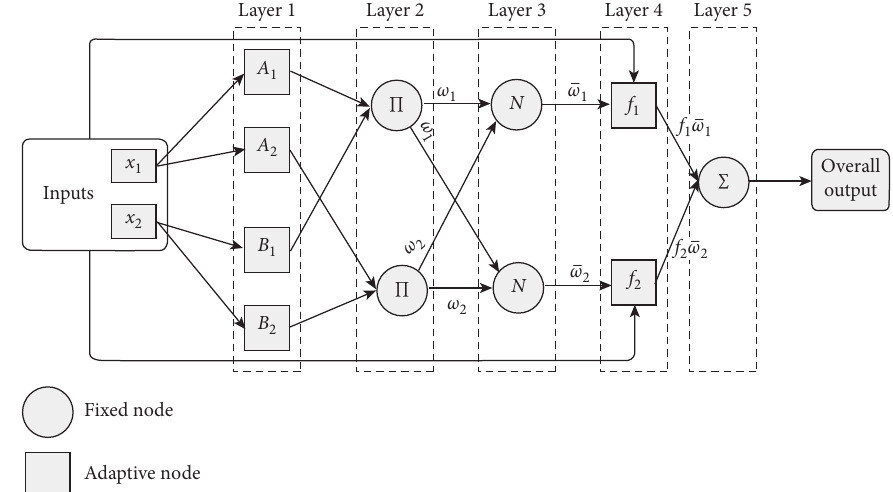
Figure 2: Illustration of basic ANFIS structure with two input parameters.